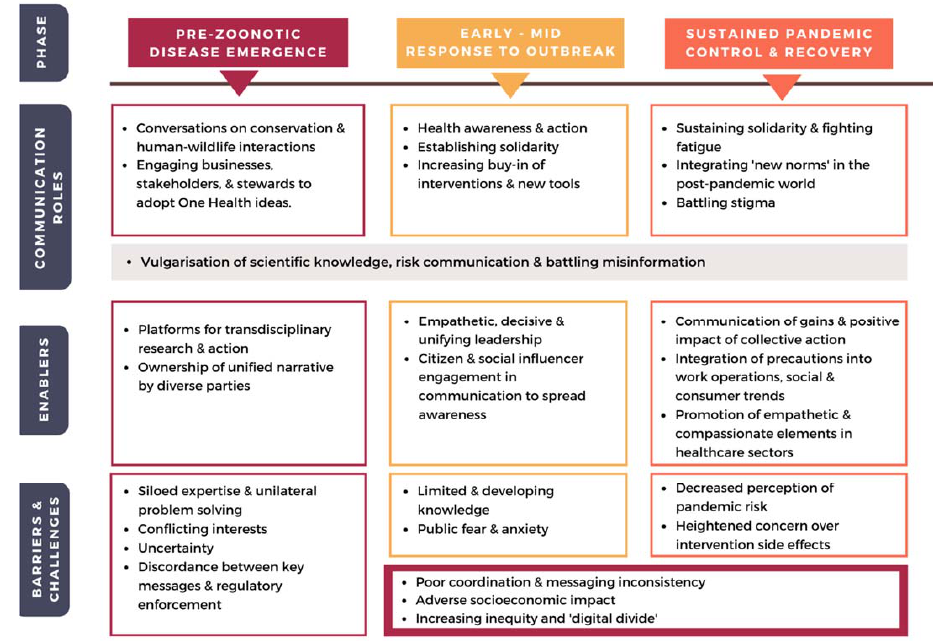
Figure 1. Summary of communication roles and their enablers and barriers at different phases of the COVID-19 pandemic.